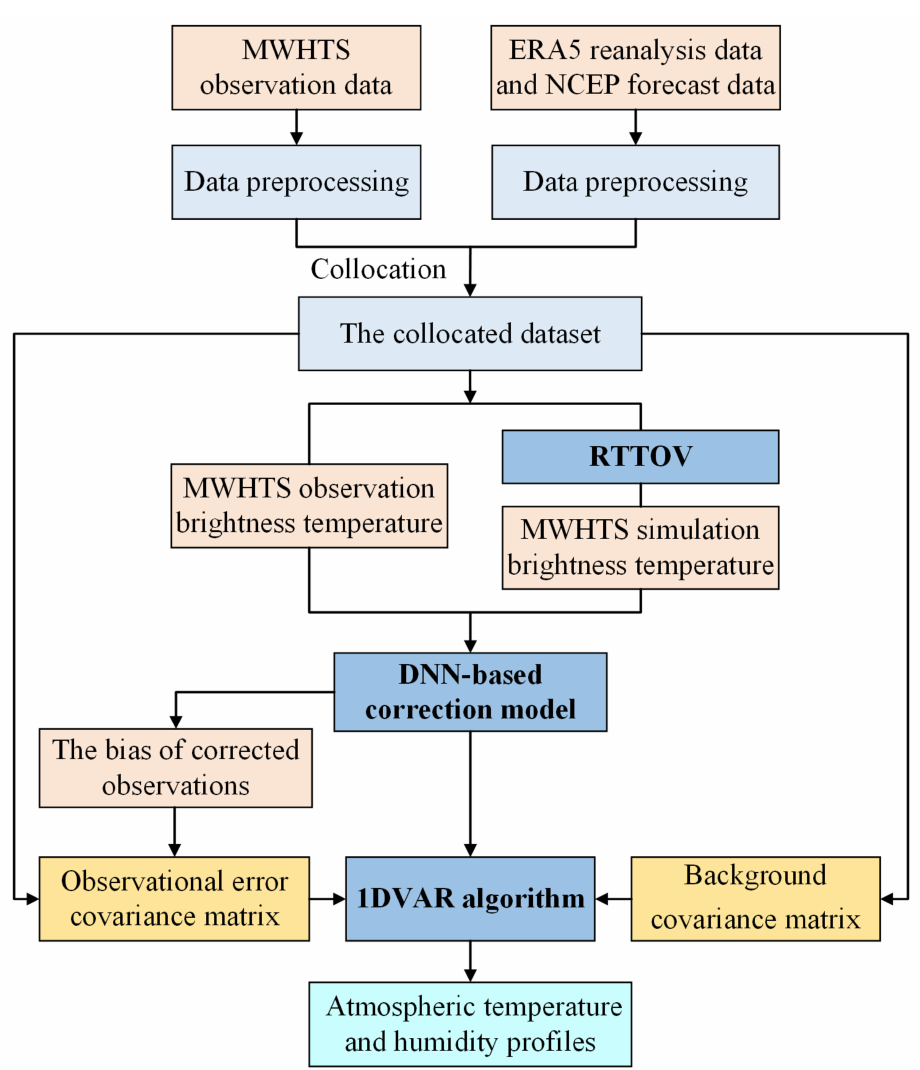
Figure 4. The flow chart of the physical retrieval algorithm for the MWHTS in this paper. First, the initial values of the atmospheric temperature and humidity profiles in the dataset are used as inputs into the RTTOV model to calculate the simulated brightness temperature. The initial state variables come from the collocated NCEP 6 h forecast temperature and humidity profiles. Second, we establish a DNN-correction model (four- layer network structure) to correct the observation bias between the observed brightness temperature from MWHTS and the simulated brightness temperature from the RTTOV model. The building process of the DNN-correction model is the same as in Section 3.1. The input of the DNN-correction model is the observed brightness temperature by MWHTS, and the output is the bias between observations and simulations. Based on the DNN- correction model, the bias of the observations for MWHTS can be corrected. Third, the observation-error covariance matrix generated by the errors of the forward models and instrument and background covariance matrix describing the atmospheric state variables is calculated, respectively. Reference [35] gives the details calculation process of these two covariance matrixes. Finally, the corrected brightness temperature, two covariance matrixes, background profiles, and initial atmospheric profiles are input into the 1DVAR retrieval system to obtain the retrieval